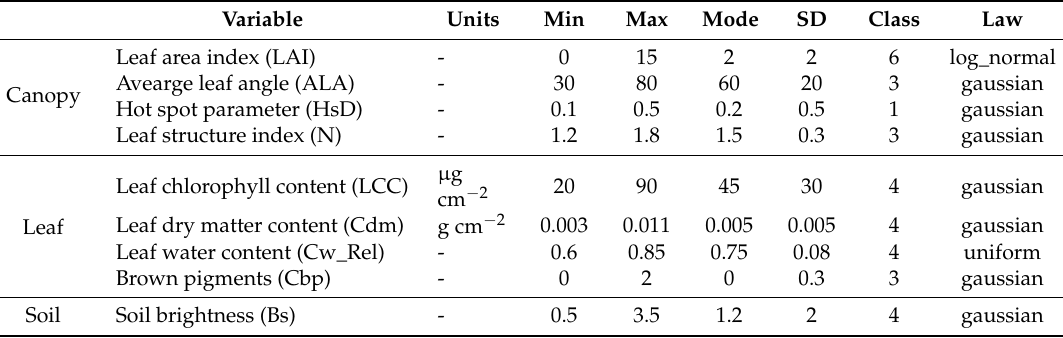
Table 1. Input parameter value ranges, number of classes, and statistical distributions used for generating the training database with the PROSAIL